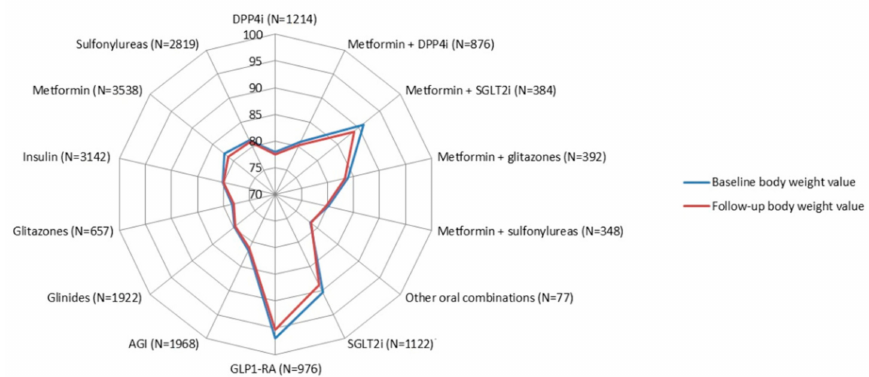
Figure A1. Prevalence (%) of AD users, stratified by calendar year and AD molecule / class. Legend: AGI = alpha-glucosidase inhibitors; DPP4i = dipeptidyl peptidase-4 inhibitors; GLP-1RA = glucagonlike peptide-1 receptor antagonists; SGLT2i = sodium–glucose linked transporter 2 inhibitors; Otheroralcombinations = fixed-dosecombinationsofglitazones + DPP4iandglitazones + sulfonylureas.